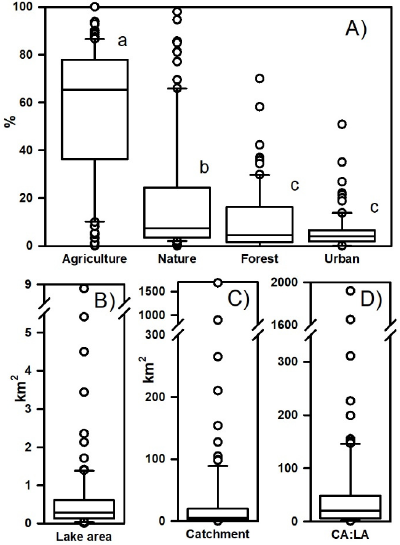
Figure 1. Catchment characteristics of newly established Danish lakes. ( A ) Percent proportion of catchments constituted by agriculture, nature, forest, and impermeable urban areas. Significant differences are denoted by a, b, and c. ( B ) The lake area of new lakes is given in km 2 . ( C ) Area of the catchments in km 2 . ( D ) Ratio between catchment area and lake area, CA:LA ( n = 90). For the 12 selected new lakes, the soil composition of the catchments was dominated by sand and loamy sand for lakes in the western regions of Denmark (FIL, LES, VIL, and BOL) and also in ALS, while loamy soils dominated in the eastern regions (BSM, GES, SYB, RBS, BUN, HIN, and EGA). Loam and humus constituted only minor proportions of the catchments (Figure 2).